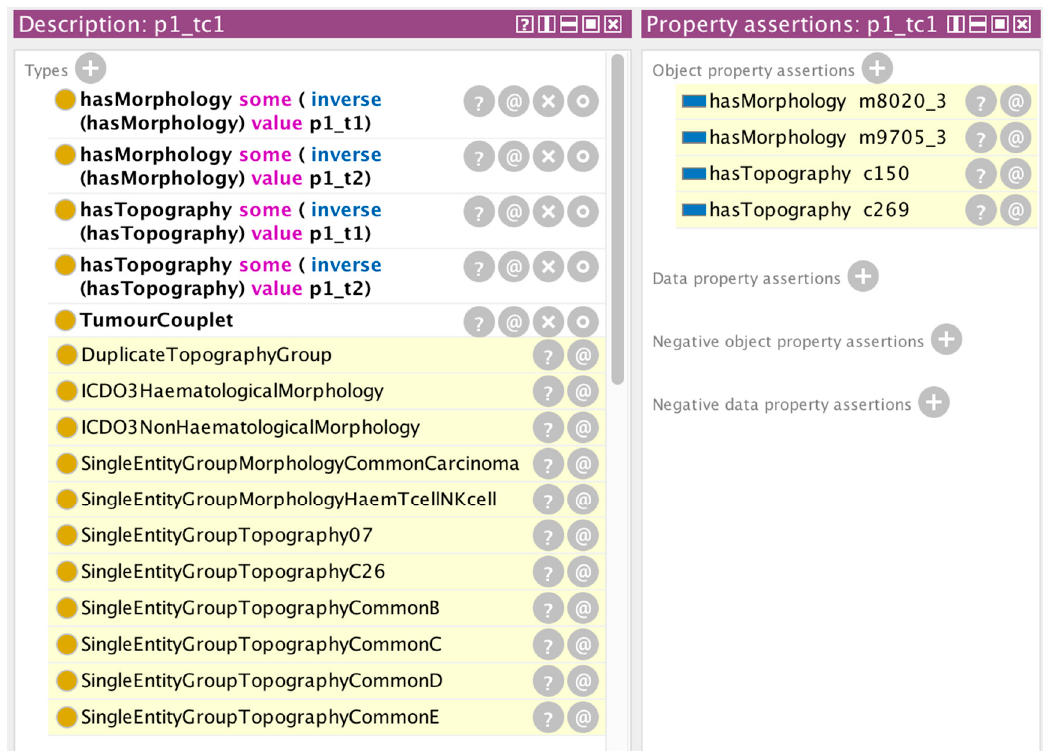
Figure 3. Results of the reasoning operation for the tumour couplet p1_tc1. Only the topography codes are equivalent (classified under DuplicateTopographyGroup) and the couplet is a valid MPT.